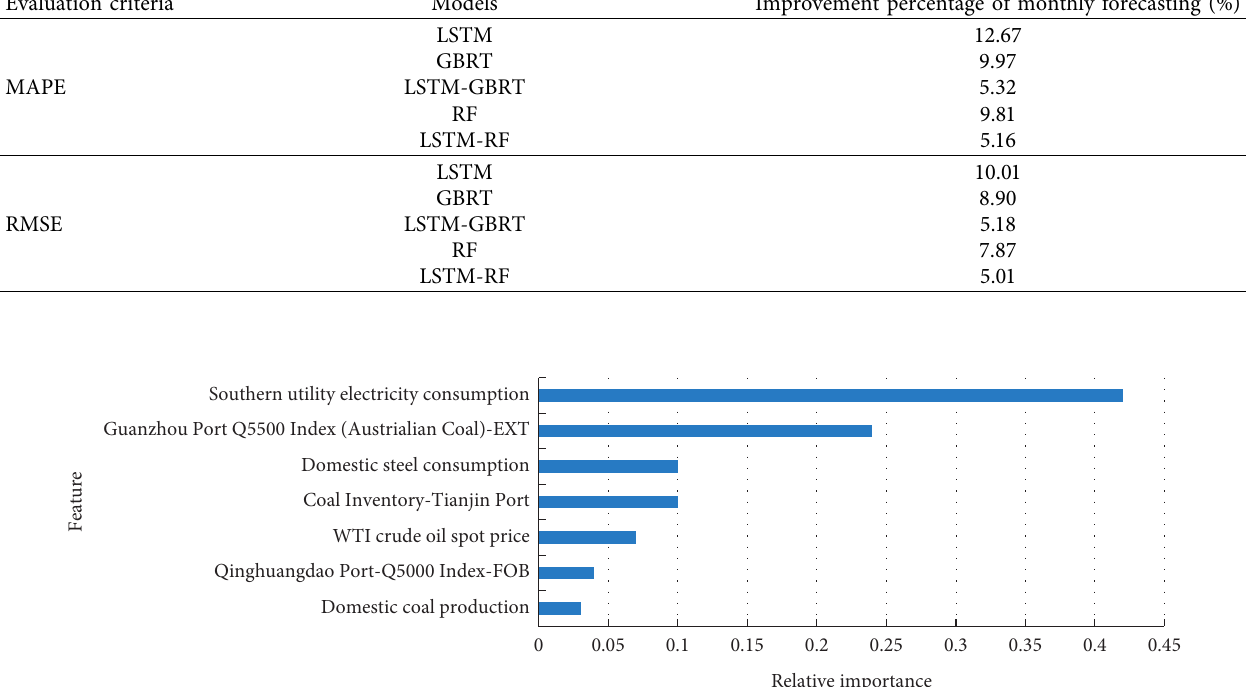
Table 8: Improvement percentage of predictive performance with adding demand and demand-related factors. Evaluation criteria